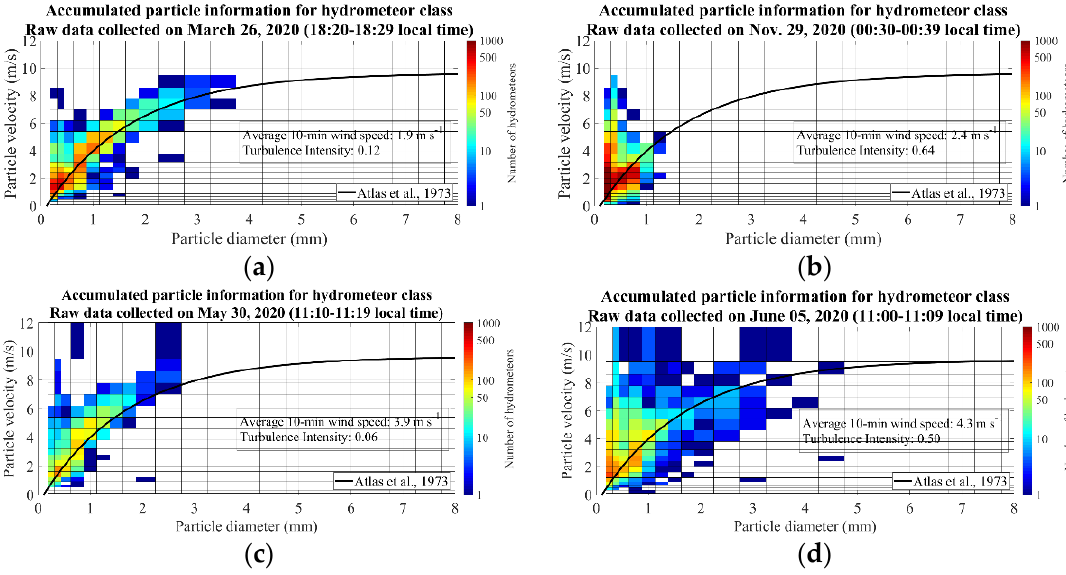
Figure 10. Example of 10-min aggregated spectrograph measured by a disdrometer under low turbulence intensity (left panels) and high turbulence intensity (right panels) conditions. More specifically, panels ( a , b ) show data collected on 26 of 1.9 and 2.4 m s − 1 was recorded, respectively. The panels ( c , d ) present the data collected on 30 May 2020 (11:10–11:19 local time) and 5 June 2020 (11:00–11:09 local time), when an average 10-min wind speed of 3.9 and 4.3 m s − 1 was recorded, respectively. The color scale indicates the number of drops in each size-velocity class. The empirical relationship between raindrop diameter and fall velocity proposed by [33] is highlighted as a black curve.